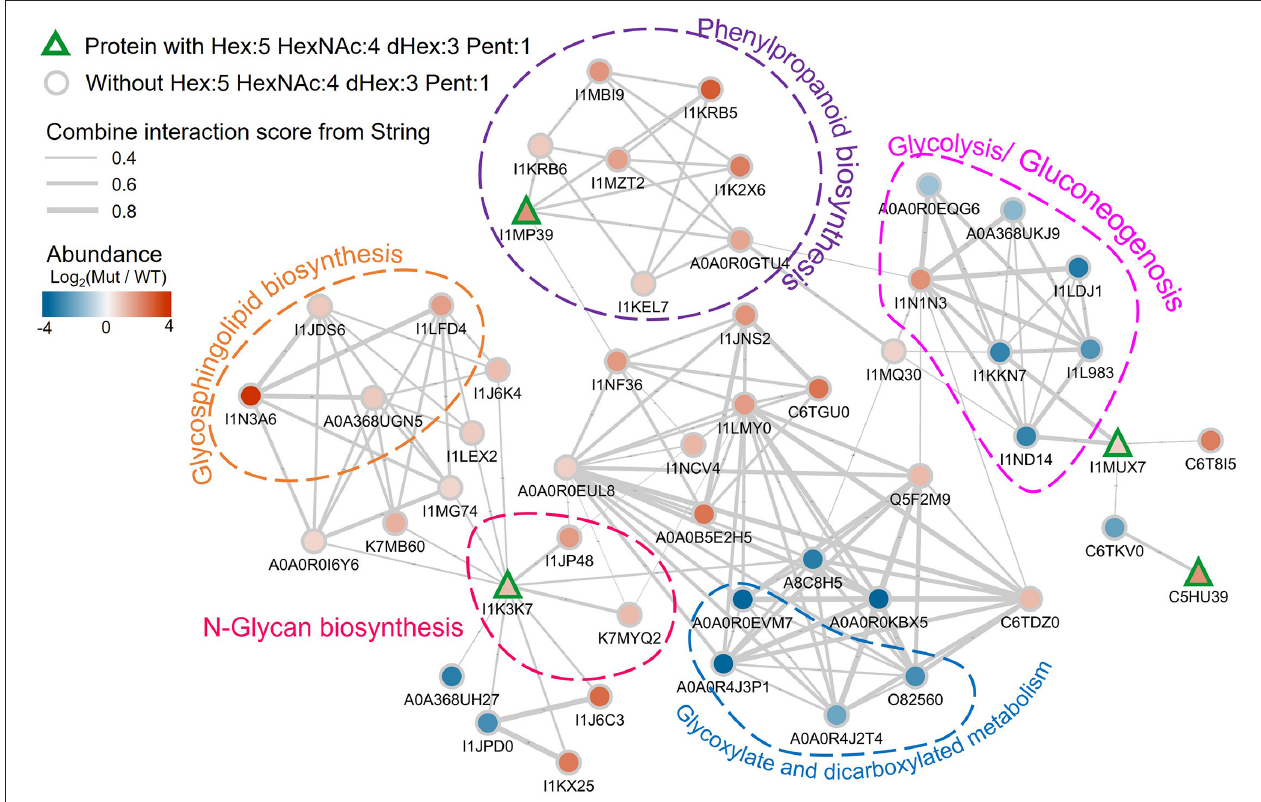
FIGURE 7 | Protein-protein interaction network plot involving the detected Lewis-a containing soybean glycoproteins in the proteomics data, labeled by their UniProt accessions. The proteins with Hex:5 HexNAc:4 dHex:3 Pent:1 are annotated with rectangles with green outlines. Other proteins are shown as gray outlined circles. The fill color of the symbols represents the log2 abundance change in the mutant vs. wildtype, with the color scale in the top left. The gray lines indicate known interactions between the proteins in the String database. The thickness of the line is scaled with their interaction scores (range is from 0.4 to 0.8 as shown by the legend in the top left). Proteins in specific pathways are highlighted with dashed